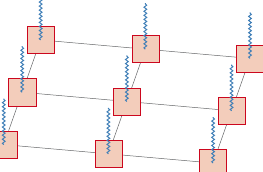
Figure 4: Pictorial representation of a PEPS. The virtual degrees of freedom con- nect tensors in the x- and y-direction since the system is three-dimensional. Physical indices / legs are drawn as wavy lines while virtual indices / legs are